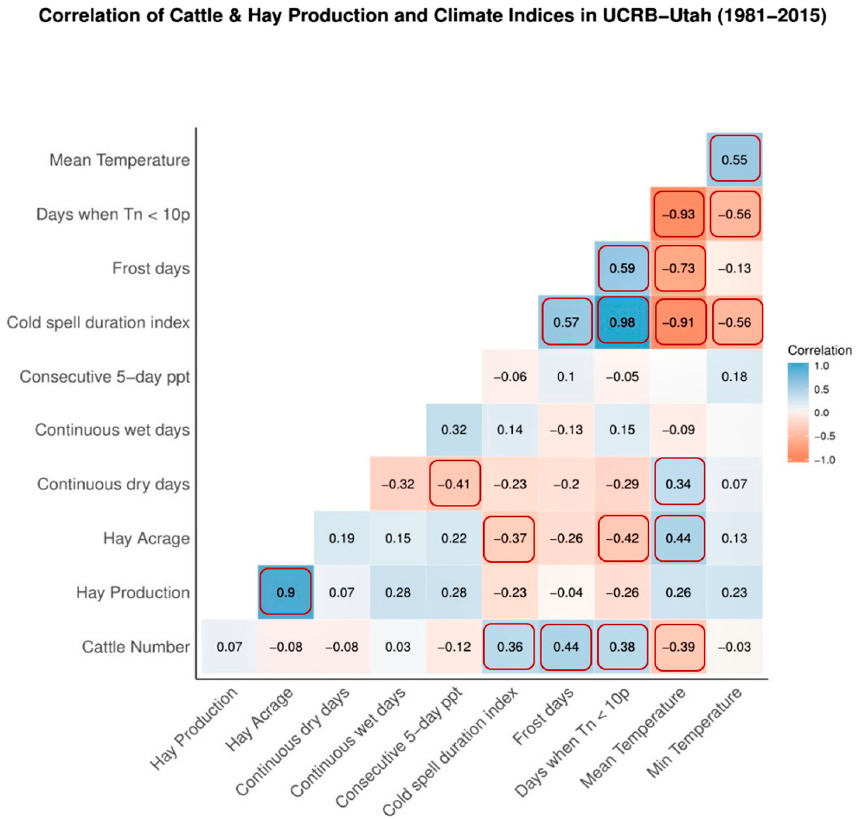
Figure 3. Correlation matrix for climate indices, cattle, and hay production.